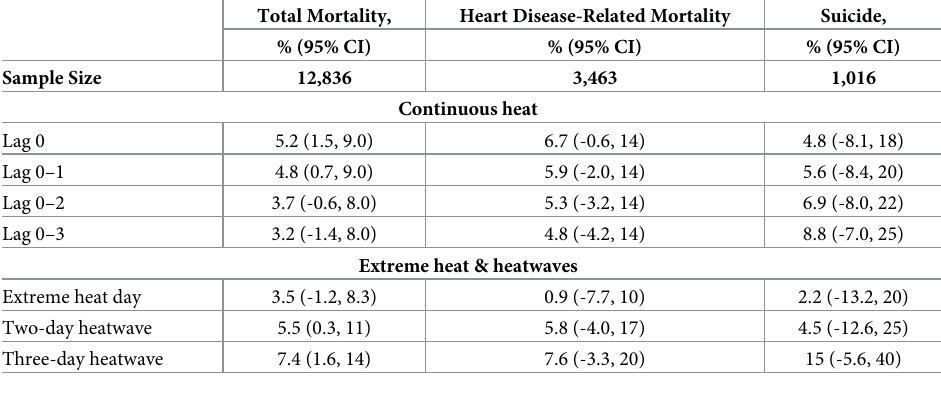
Table 2. Percent change in total mortality, heart disease-related mortality, and suicides associated to a 10˚F increase in temperature averaged over a period up to three days, and extreme heat and heatwave days during sum- mer months a